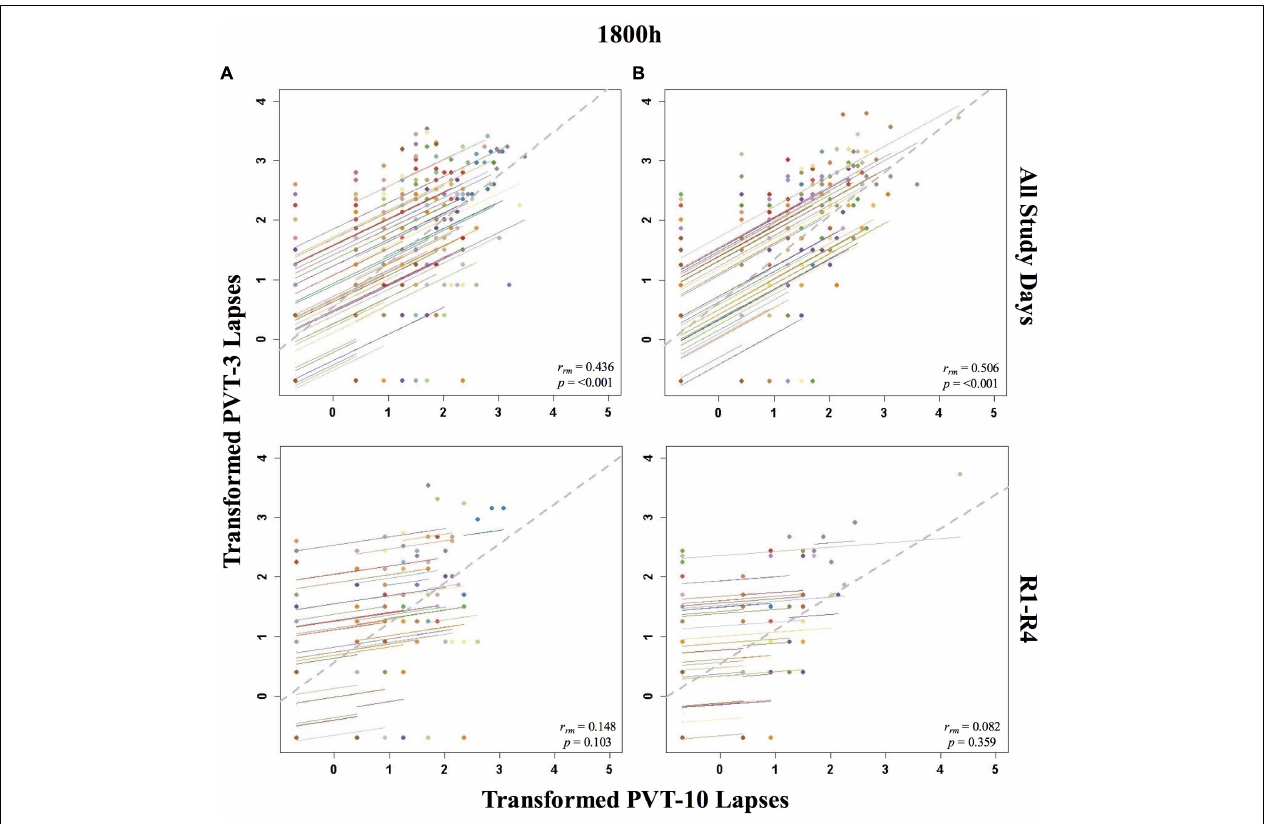
FIGURE 3 | Rmcorr plots of repeated-measures correlations between 10-min Psychomotor Vigilance Test (PVT-10) and 3-min Psychomotor Vigilance Test (PVT-3) transformed lapses at 1800 h across the entire study (All Study Days) and across only recovery days 1–4 (R1-R4) for Condition A (A) and Condition B (B) . Each color represents a distinct participant with each point showing performance on both measures at one time point while the corresponding line shows the rmcorr fit for that participant (Bakdash and Marusich, 2020; R Core Team, 2020). The gray dashed line represents the regression line obtained by ignoring repeated measurements and treating the data as independent observations; r rm represents the common within-individual association (rmcorr). Rmcorr effect sizes were interpreted as follows: 0.00–0.29, negligible; 0.30–0.49, weak; 0.50–0.69, moderate; 0.70–0.89, strong; and 0.90–1.00, very strong. Values were transformed by adding 0.5 and natural log transforming the